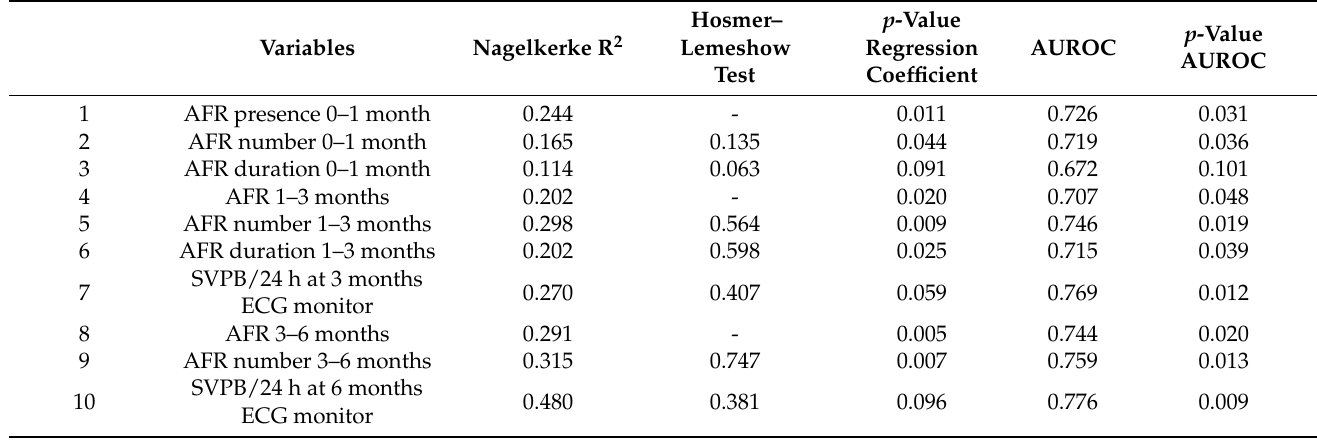
Table A2. Selection of independent predictors by bivariate linear regression/univariate analysis for late AFR (6–12